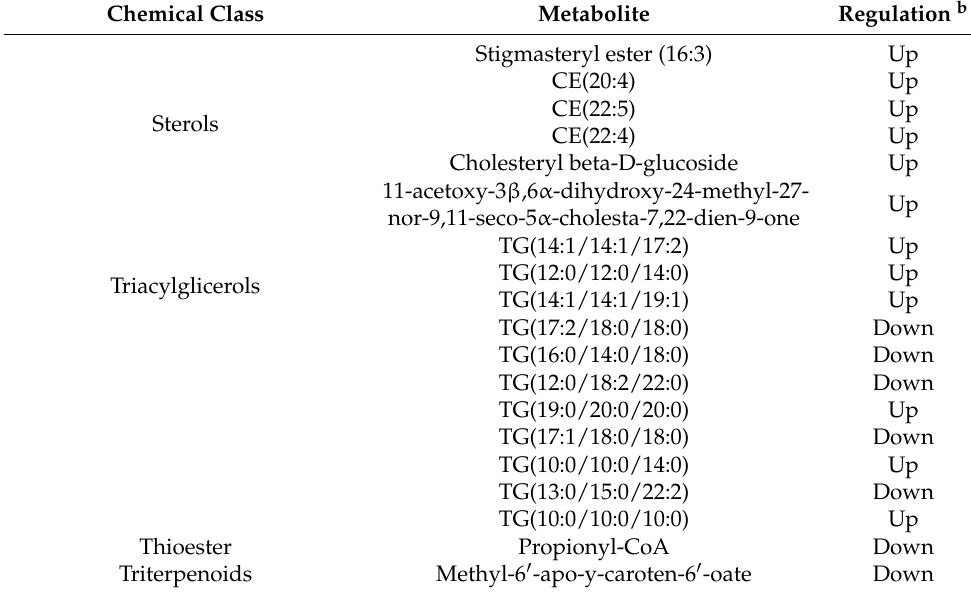
Table 2. Cont. Chemical Class Metabolite